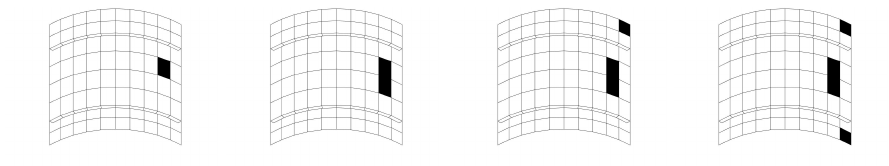
Figure 8. Stiffened fuselage section problem, Case (1), macroscale analysis: optimal sensor placement corresponding to (from left to right): N M = 1; N M = 2; N M = 3 and N M = 4.